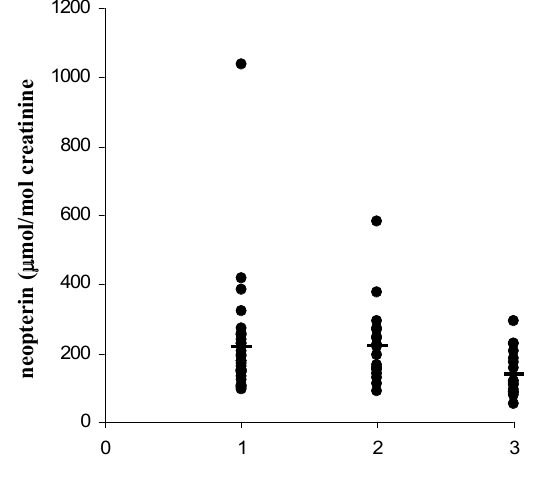
Figure 1. Dot plot of urinary neopterin measurements in patients without diabetic foot (1), patients with dia- betic foot (2), and healthy controls (3); horizontal lines indicate mean